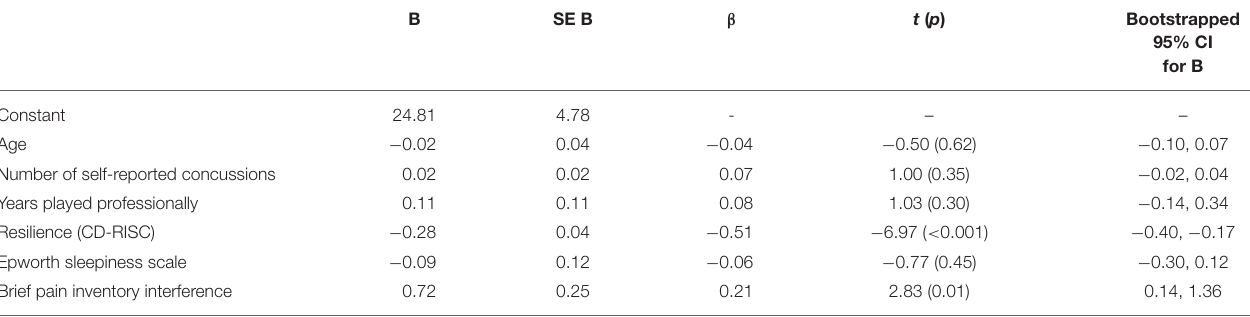
TABLE 6 | Simultaneous regression model with DASS depression as the